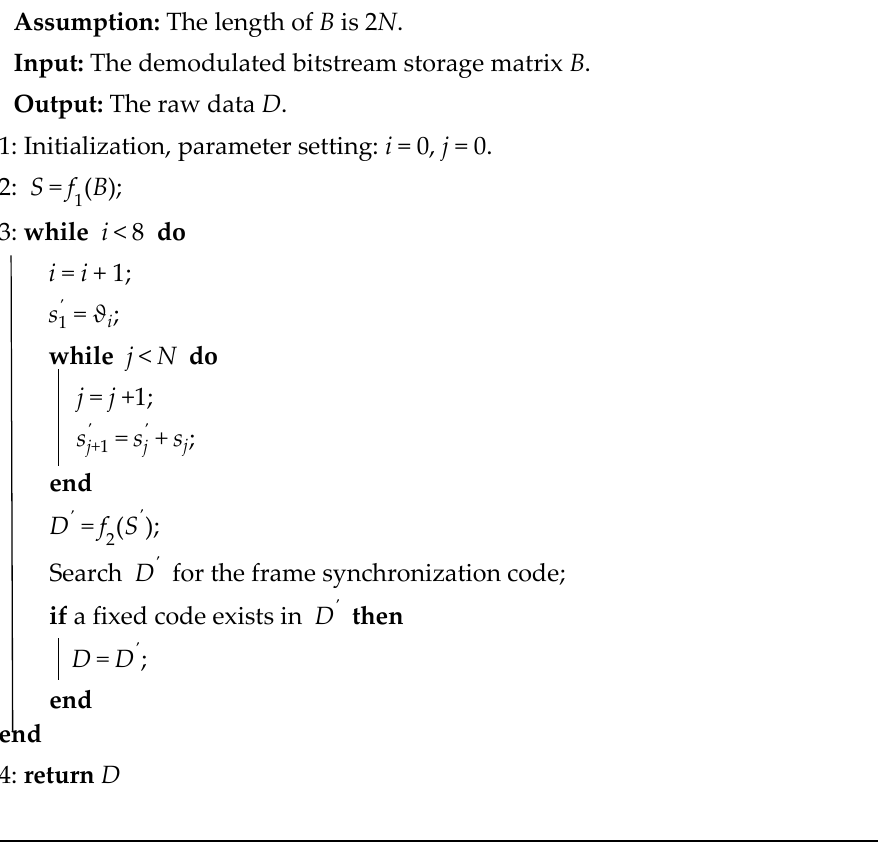
Algorithm 1 Recover the raw data from the demodulated bitstream